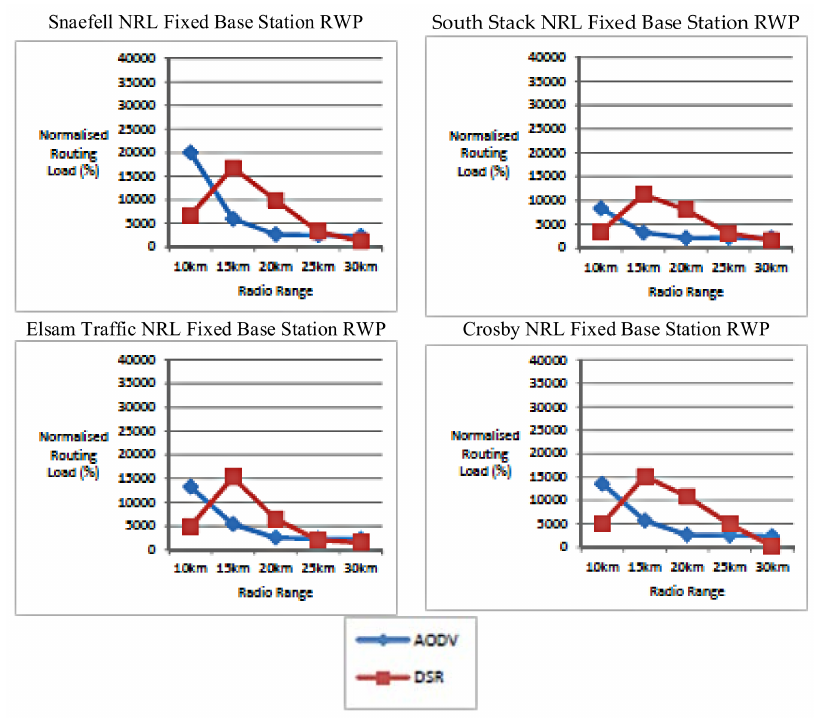
Figure 17. Fixed Base Station Random Waypoint Shipping Model with Normalized Routing